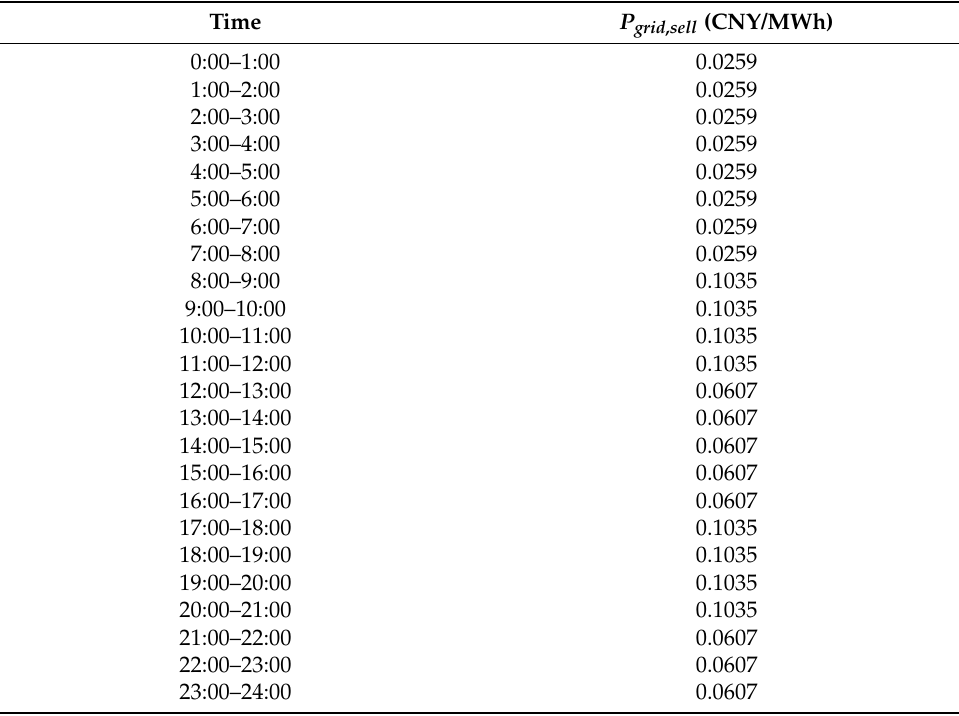
Table A2. Values of time-varying electricity purchasing price in Case study.